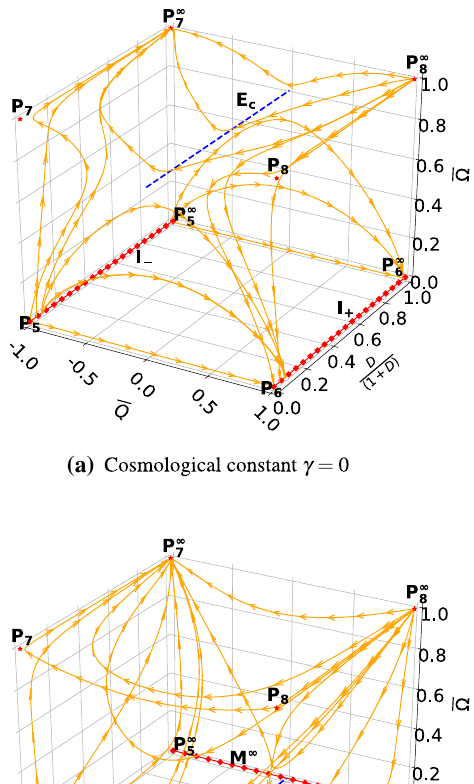
dynamics at the invariant set solutions is represented in the compact space ( ¯ D ), Q ) for γ = 0 and γ = 2.